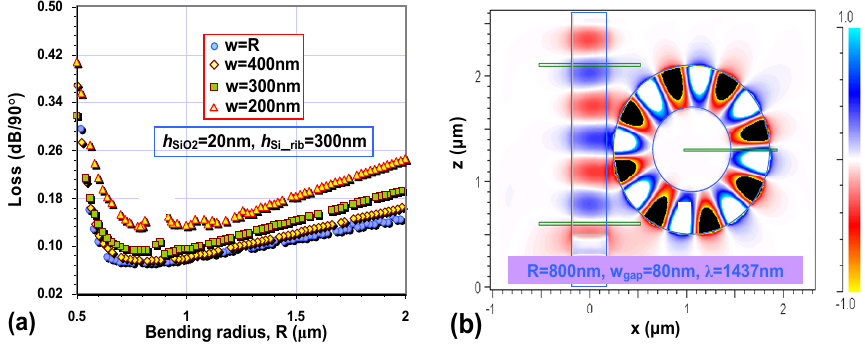
Figure 2. Electrical field distribution E y ( x , y ) of the TM fundamental mode for the cases of ( a ) R = 1 µ m; ( b ) R = 800 nm; ( c ) R = 500 nm. The other parameters are: the Si core thickness h Si = h Si_rib = 300 nm, the SiO 2 nano-slot thickness h SiO2 = 20 nm, the core width w co = 400 nm [16].